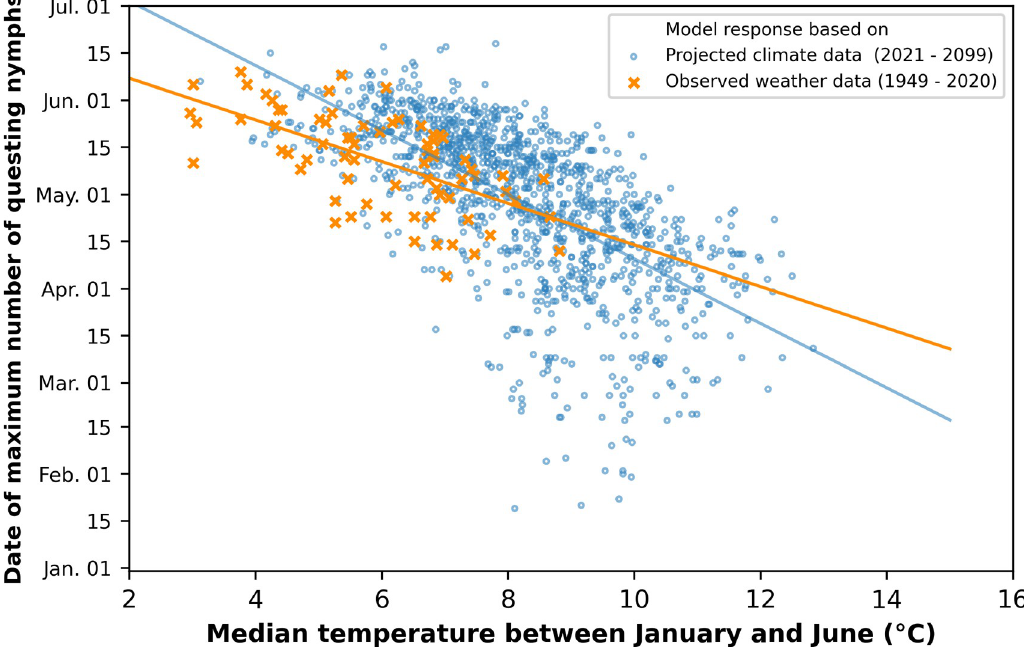
Fig 5. Relationship of the median temperature between January and June (x-axis) and the date of the maximum number of questing nymphs on the model landscape (y-axis). Each data point corresponds to a simulation run of a particular year. Orange crosses represent IRIS model runs with observed weather data leading to a correlation coefficient of r = -0.61. Blue circles represent IRIS model runs with projected climate data for the period 2021–2099 leading to a correlation coefficient of r = -0.65. There are 15 data points for each year simulated with data from climate models (blue dots). Each of them represents a different climate model.